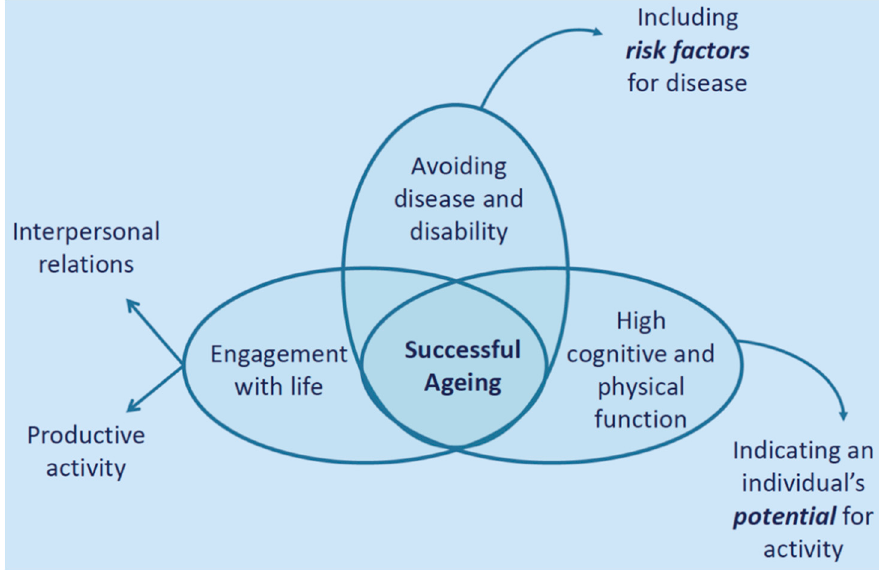
Figure 1. Rowe and Khan’s definition of successful ageing.